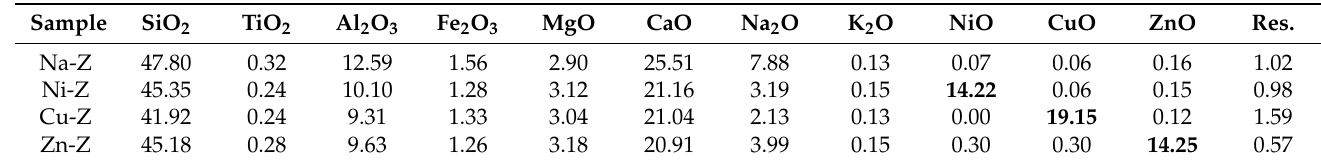
Table 1. Chemical compositions (wt. %) of the aggregates.